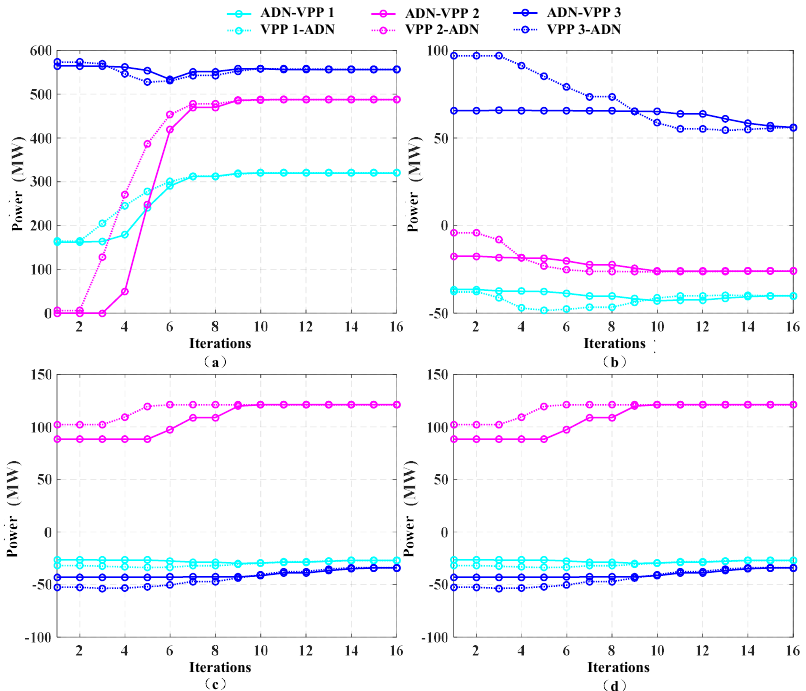
Figure 7. Iteration curve of active power of ADN and VPPs ( a ) 3rd period; ( b ) 9th period; ( c ) 15th period; ( d ) 20th period.